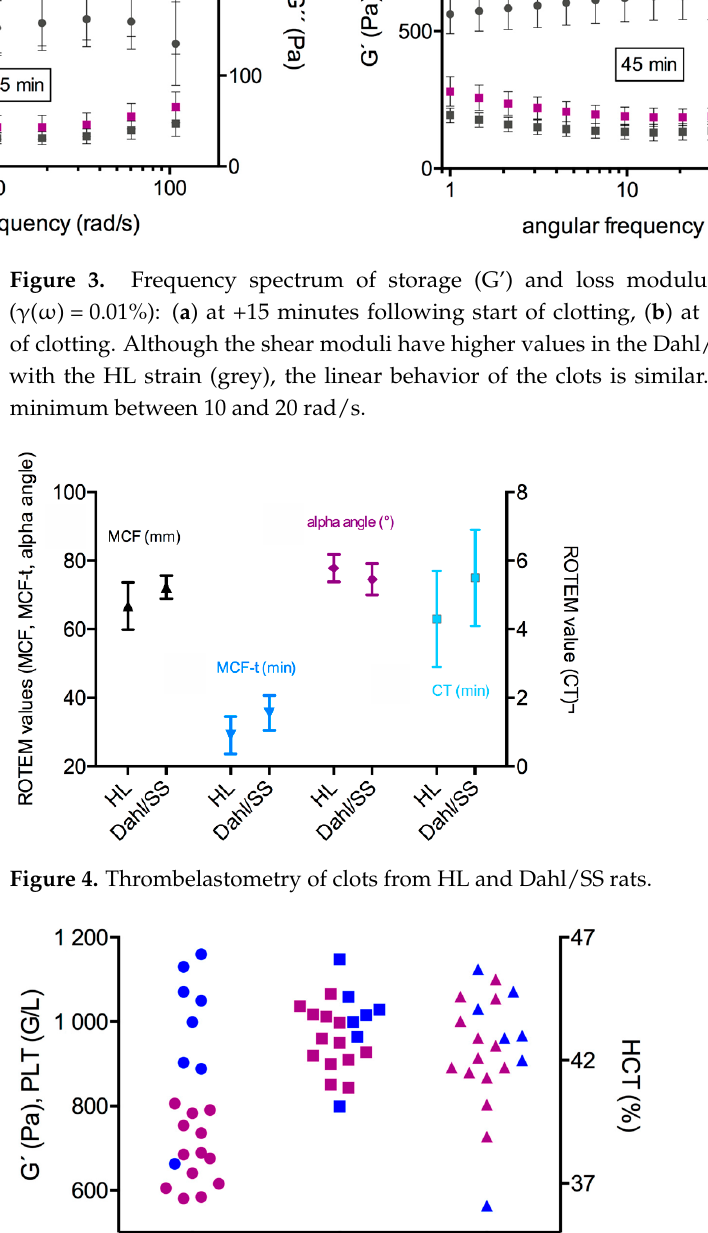
Figure 5. Stiffness of fully formed clots (G’ plateau ) and hematological values in the sex groups (blue: males; purple: females). Clot stiffness was higher in male rats, but platelet count (PLT) and hematocrit (HCT) values of males and females